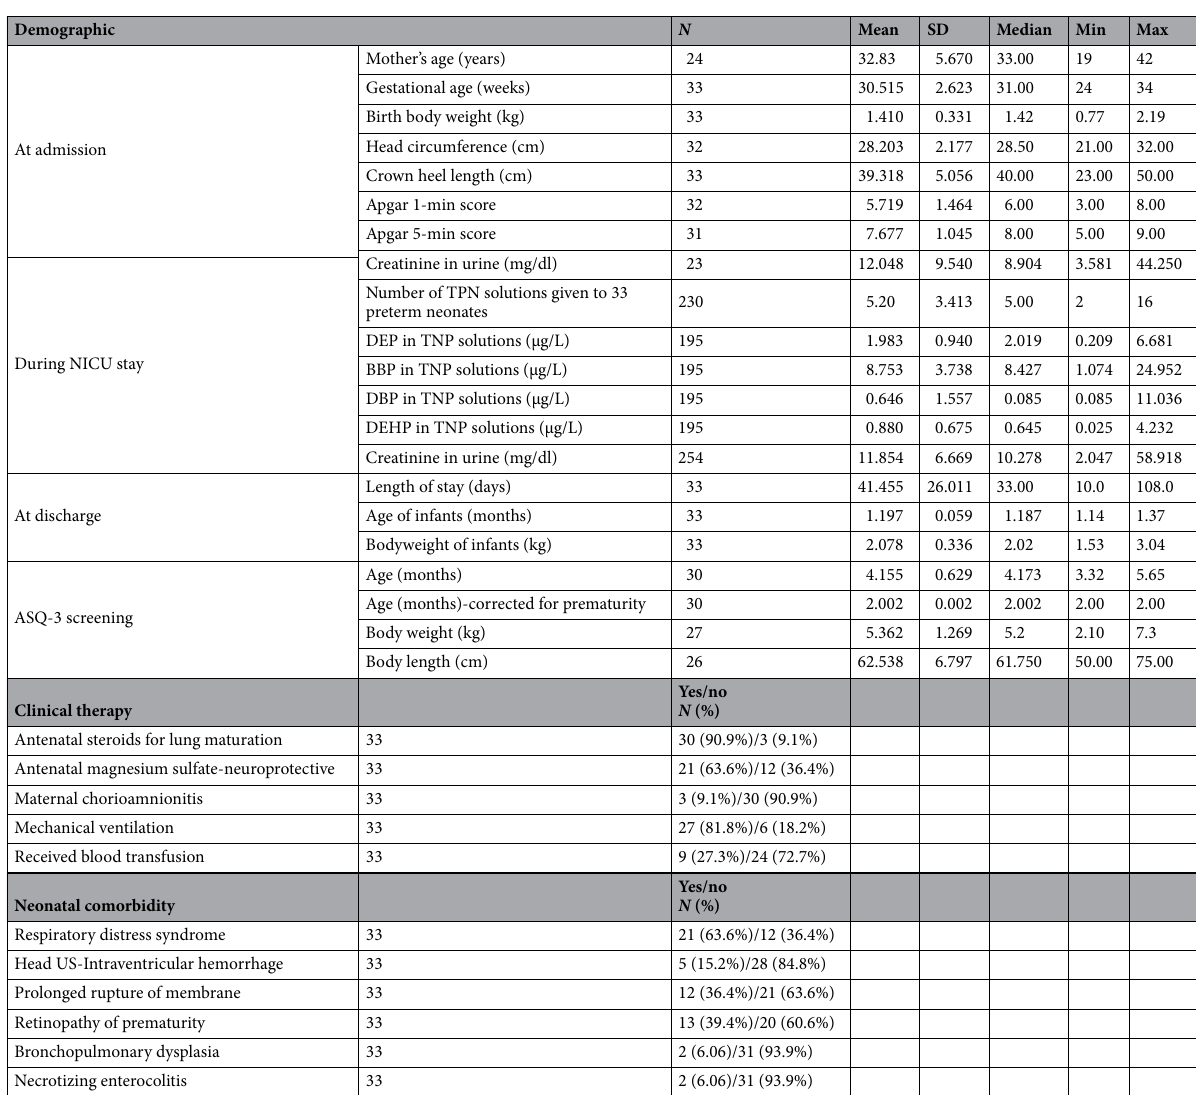
Table 1. The demographic and clinical characteristics of premature neonates admitted to the NICU (2020–